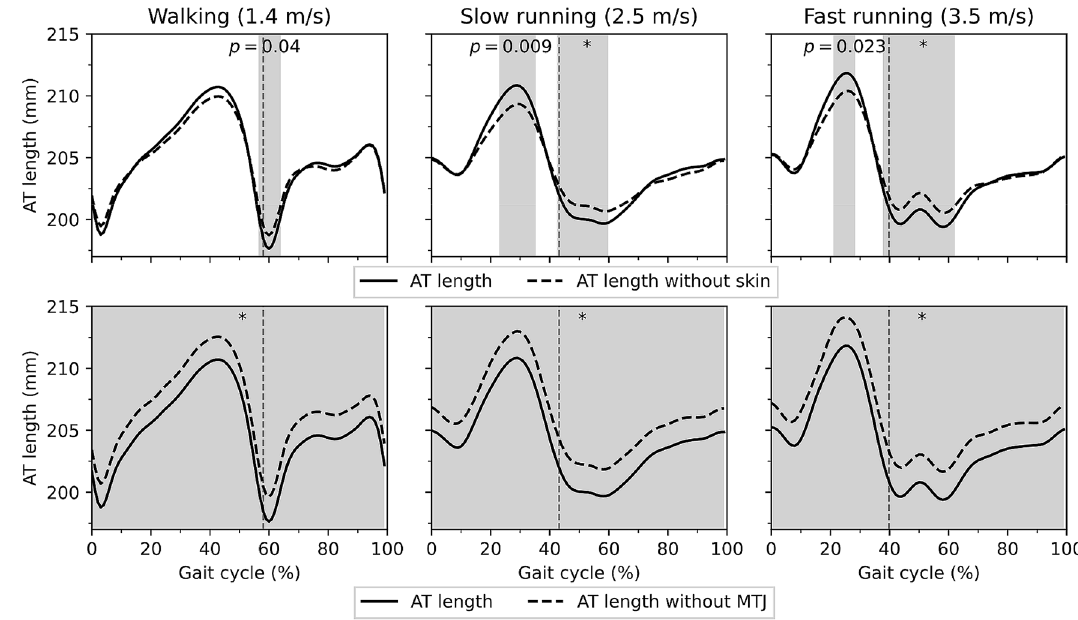
Figure 3. The first row shows the contribution of the skin-to bone displacement to AT length; the second row shows the contribution of the projection of the MTJ to the skin surface to AT length. AT length: The length of AT considering its curve-path shape, skin-to-bone displacement and the projection of the myotendinous junction (MTJ) to the skin surface. AT length without skin: AT length considering its curve-path shape and the projection of the MTJ to the skin surface. AT length without MTJ: The length of AT considering the curve-path shape and skin-to-bone displacement; the x-axis is normalized to the gait cycle. The filled gray areas indicated a significant difference between methods as result of the SPM paired t-test. The gray dashed vertical lines separate the contact and swing phase. The ‘*’ sign indicates the p-value < 0.001. Otherwise, the exact p-values are annotated in the figure. (the average of eleven participants with ten gait cycles). The maximum tendon force and elongation during the isometric MVCs were 5.523 ± 0.552 kN and 14.0 ± 2.5 mm, respectively. The adjusted r-square from the force–elongation of the quadratic equation (Eq. (5)) was, on average, 0.98 ± 0.01 ( p < 0.001), and the average values of the two constants a and b were 8.7 and 181, respectively. Strain, force, strain energy, and the EMG activity of the three investigated muscles during walking and running are depicted in Fig.